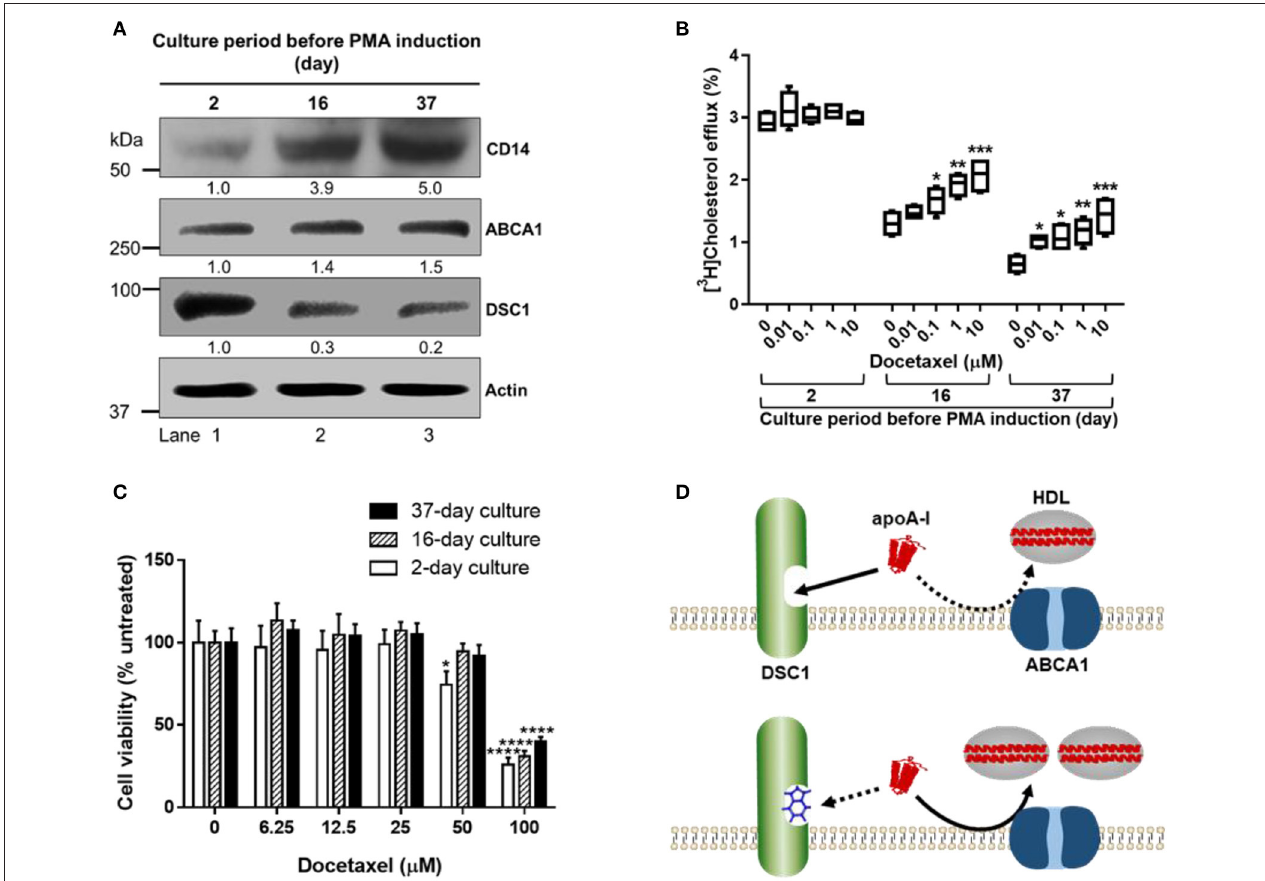
FIGURE 2 | New strategies to promote ABCA1-mediated cholesterol efflux in differentiated macrophages. (A) THP-1 monocytes were cultured at the density of 2.0 × 10 6 /ml in RPMI 1640 medium supplemented with 10% fetal bovine serum and 100 IU penicillin and 100 mg/ml streptomycin. The culture medium was refreshed every 2–3 days (Mondays, Wednesdays, and Fridays) with counting/reseeding the cells at the density of 2.0 × 10 6 /ml every 3–4 days (Mondays and Fridays). The cells cultured for 2, 16, or 37 days were treated with 100ng/ml of PMA for 3 days to differentiate monocytes into macrophages, washed with RPMI 1640 three times, rested for 2 days in the PMA-free culture medium, and lysed to determine protein expression levels by immunoblotting. Numeric values shown below the CD14, ABCA1, and DSC1 blots represent band densities normalized to actin and relative to the 2-day cultured cells (lane 1). (B) At the end of the 2 days resting period, THP-1 cells were incubated with 50 µ g/ml of acetylated LDL and 1 µ Ci/ml of [ 3 H]-cholesterol for 24h, equilibrated for 24h, and treated with 5 µ g/ml of apoA-I for 6h to measure ABCA1-mediated cholesterol efflux to apoA-I. The indicated concentrations of docetaxel were added during the equilibration and apoA-I treatment period ( 35). Results were expressed as percentage of total (cell plus medium) [ 3 H]-sterol appearing in the medium. Data values were displayed by using a box and whisker plot ( n = 4). One-way analysis of variance with Dunnett’s post-hoc correction was performed to calculate multiplicity-adjusted p -values. * p < 0.05; ** p < 0.01; *** p < 0.001 compared with the untreated control in each group. (C) At the end of the 2 days resting period, THP-1 cells were treated with indicated concentrations of docetaxel for 3 days prior to performing the sulforhodamine B cytotoxicity assay (35). Values are the mean ± standard deviation of triplicate determinations. Statistical analysis was performed as described above. * p < 0.05; **** p < 0.0001 compared with the untreated control in each group. (D) DSC1 targeting strategies. The binding of apoA-I to DSC1 prevents ABCA1-mediated cholesterol efflux to apoA-I, thus small molecules blocking apoA-I-DSC1 interactions may hold therapeutic potential for reducing atherogenic cholesterol toxicity. In addition to small molecules such as docetaxel, peptide- and antibody-based targeting strategies may also be